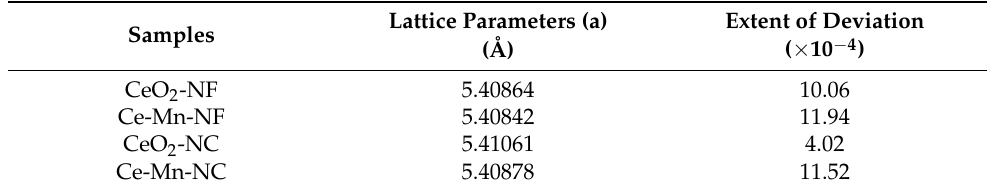
Table 1. Lattice parameters and extent of expansion of synthesized samples compared with those of pure CeO 2